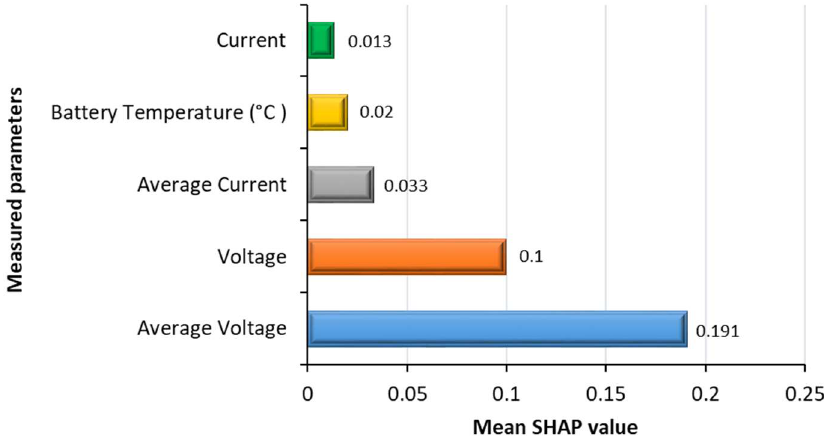
Figure 18. Feature importance of the hybrid CNN-GRU-LSTM model trained with the four tempera- ture data altogether.